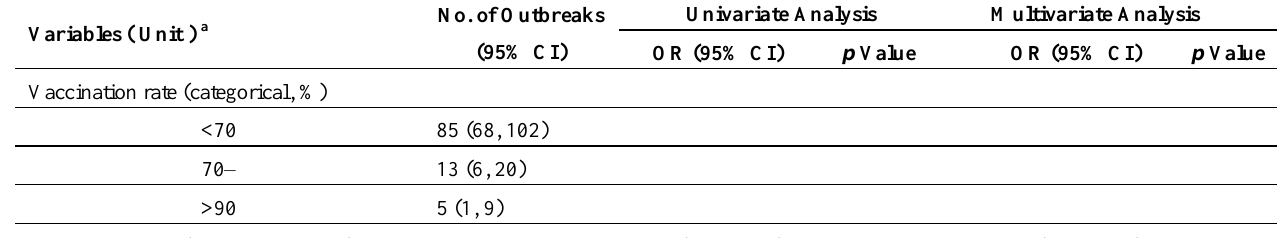
Table 2. The association between HPAI H5N1 outbreaks and potential factors by panel logistic regression